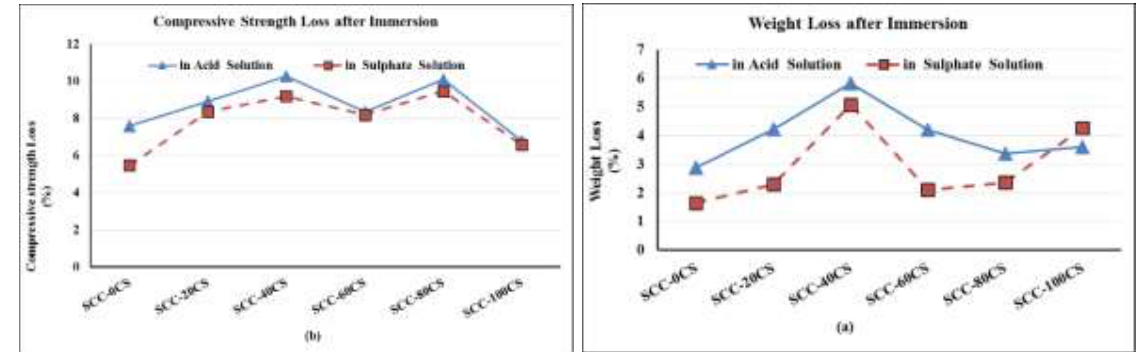
Figure 9. Wight and compressive strength loss of specimens in acidic and sulfate corrosive environment after 30